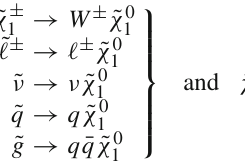
-LSP. All final 1